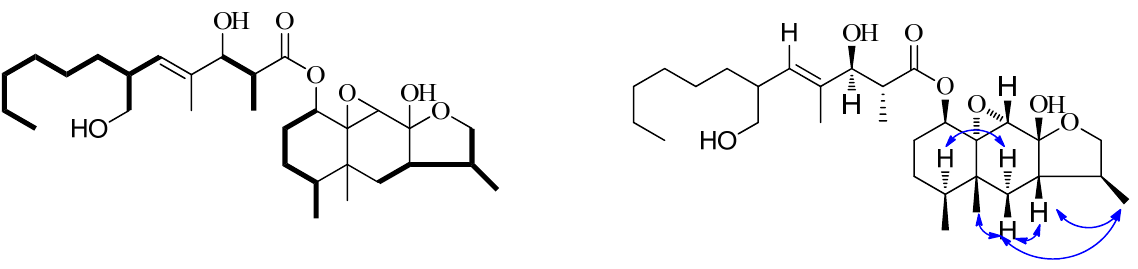
Figure 3. The 1 H, 1 H-COSY and key selected NOESY correlations of 1